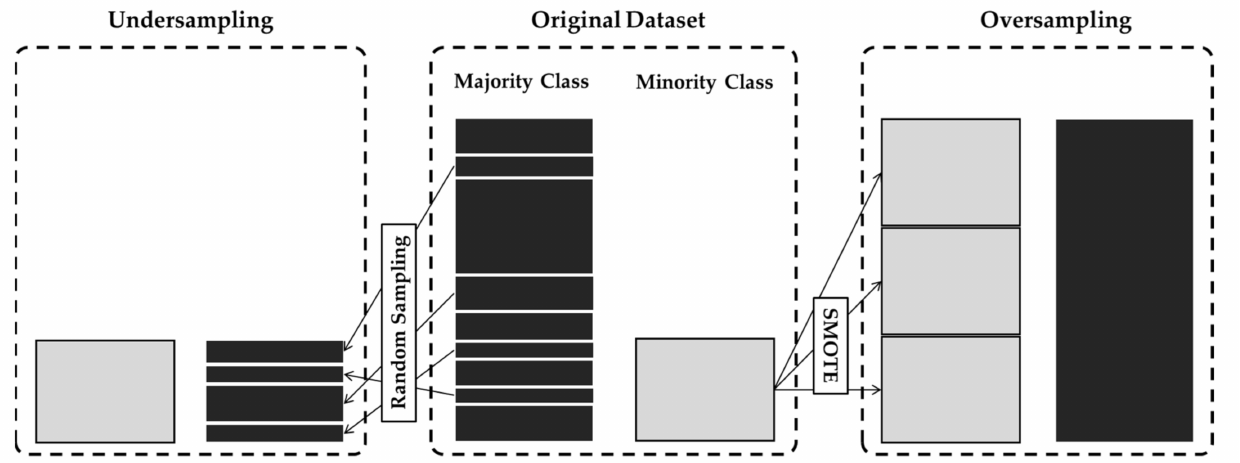
Figure 2. Undersampling and oversampling in the training set. In undersampling, the data belonging to the majority class were randomly partitioned to have the same length as the minority class. In oversampling, the data in the minority class were permuted and replicated to have the same length as those of the majority